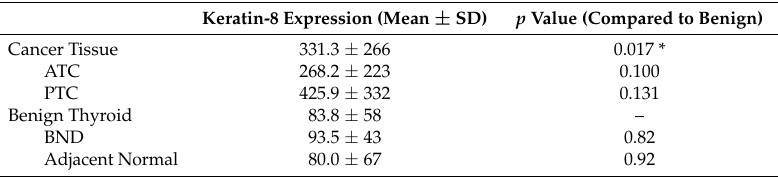
Table 2. Keratin-8 quantitative expression by multispectral